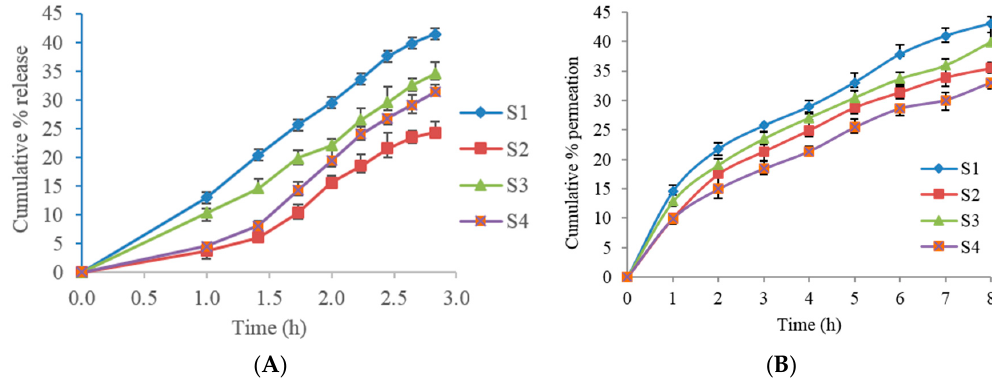
Figure 5. Cumulative percent permeation over 8 h following application of proniosome gels, S1–S4. ( A ) With Strat-M™ membrane; ( B ) with freshly excised albino rat skin.